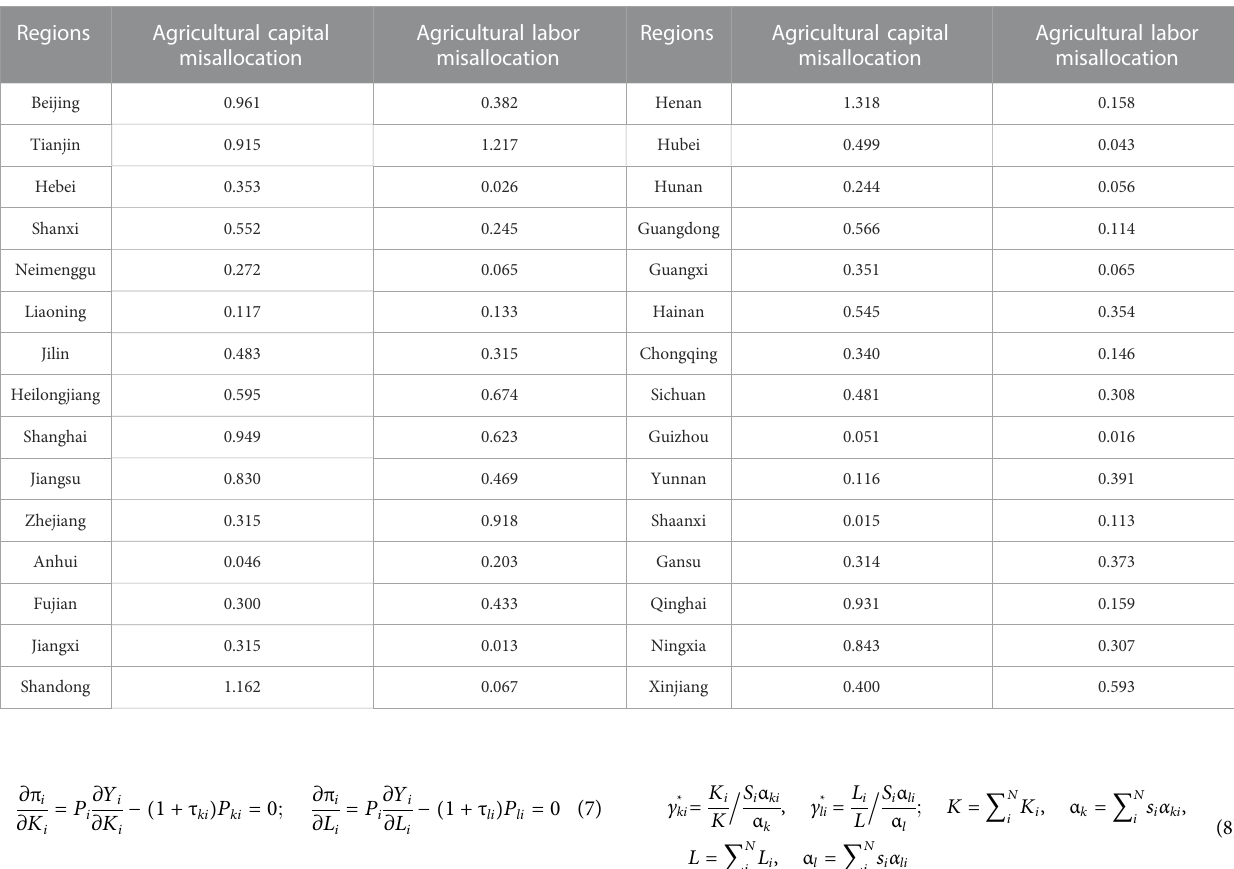
TABLE 3 Calculation results of China ’ s agricultural capital and labor misallocation in 2020.